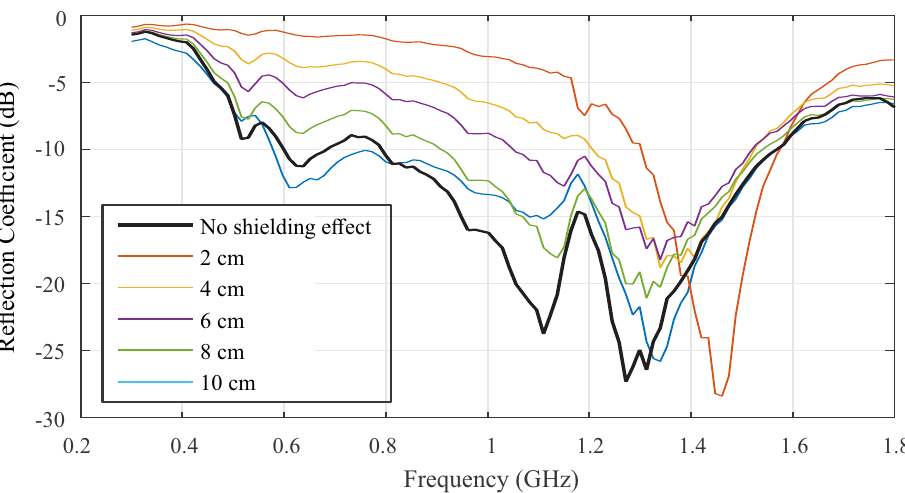
Figure 8. Electromagnetic shielding effect over the bio-inspired reflection